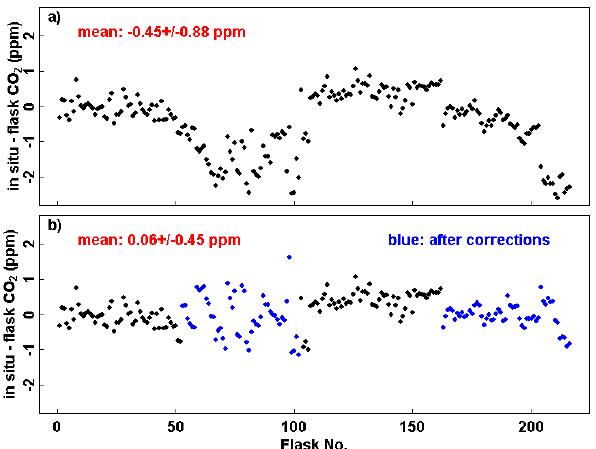
Fig. 9. Comparison of in situ measurements with flask CO 2 mixing ratio measurements over Bialystok Tall Tower for 216 flasks from 22 flights between April 2008 and July 2009. Note the differences between (a) averaged in situ and flask CO 2 mixing ratios for blind comparison and (b) after correcting the insufficient drying effect for 104 flasks from 10 flights. The averaged values and standard deviations of the differences in (a) and (b) are shown in the plot in